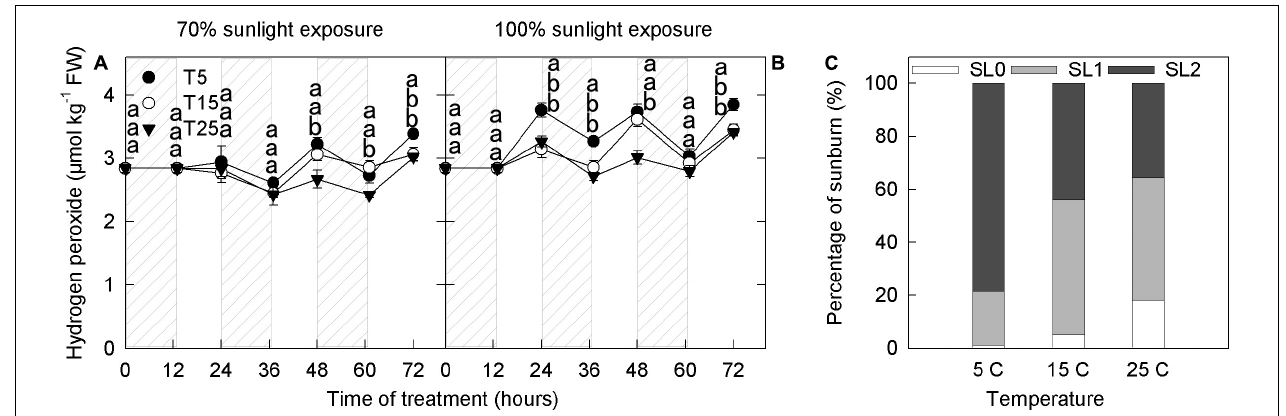
FIGURE 4 | Concentration of hydrogen peroxide in the peel of “Fuji” apple fruits exposed to different nighttime temperatures and sunlight intensities and levels of sunburn under natural light in the peel of fruits exposed to different nighttime temperatures. Concentration of hydrogen peroxide in the peel of “Fuji” apple fruits exposed to nighttime temperatures of 5, 15, and 25 ◦ C and 70% sunlight intensity (A) and 100% sunlight intensity (B) . Levels of sunburn under natural light in the peel of fruits exposed to nighttime temperatures of 5, 15, and 25 ◦ C (C) . Different lowercase letters indicate significant difference among treatments at P <